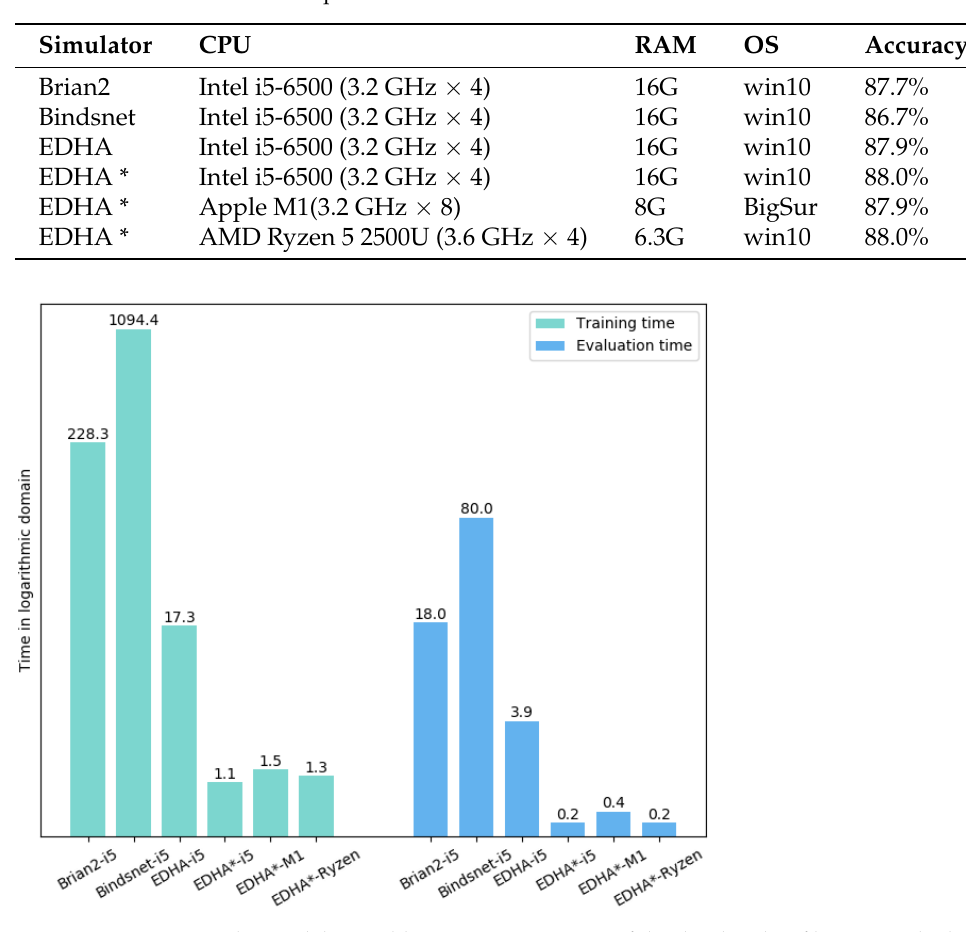
Figure 10. Time spent by models in Table 5. For convenience of display, height of bars are calculated by h = log 10 ( time )